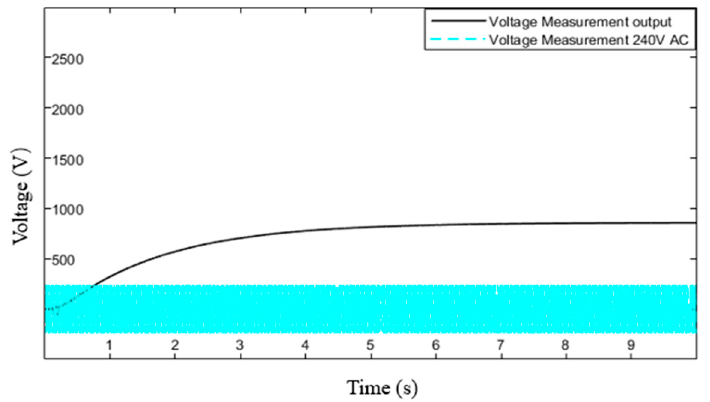
Figure 13. Simulated waveforms of the output of rectifier and filter circuit under 240 V AC for measured L 1 and R 1 values (Sample B). Table 4. Comparison of nominal and measured values of each component (Sample A)